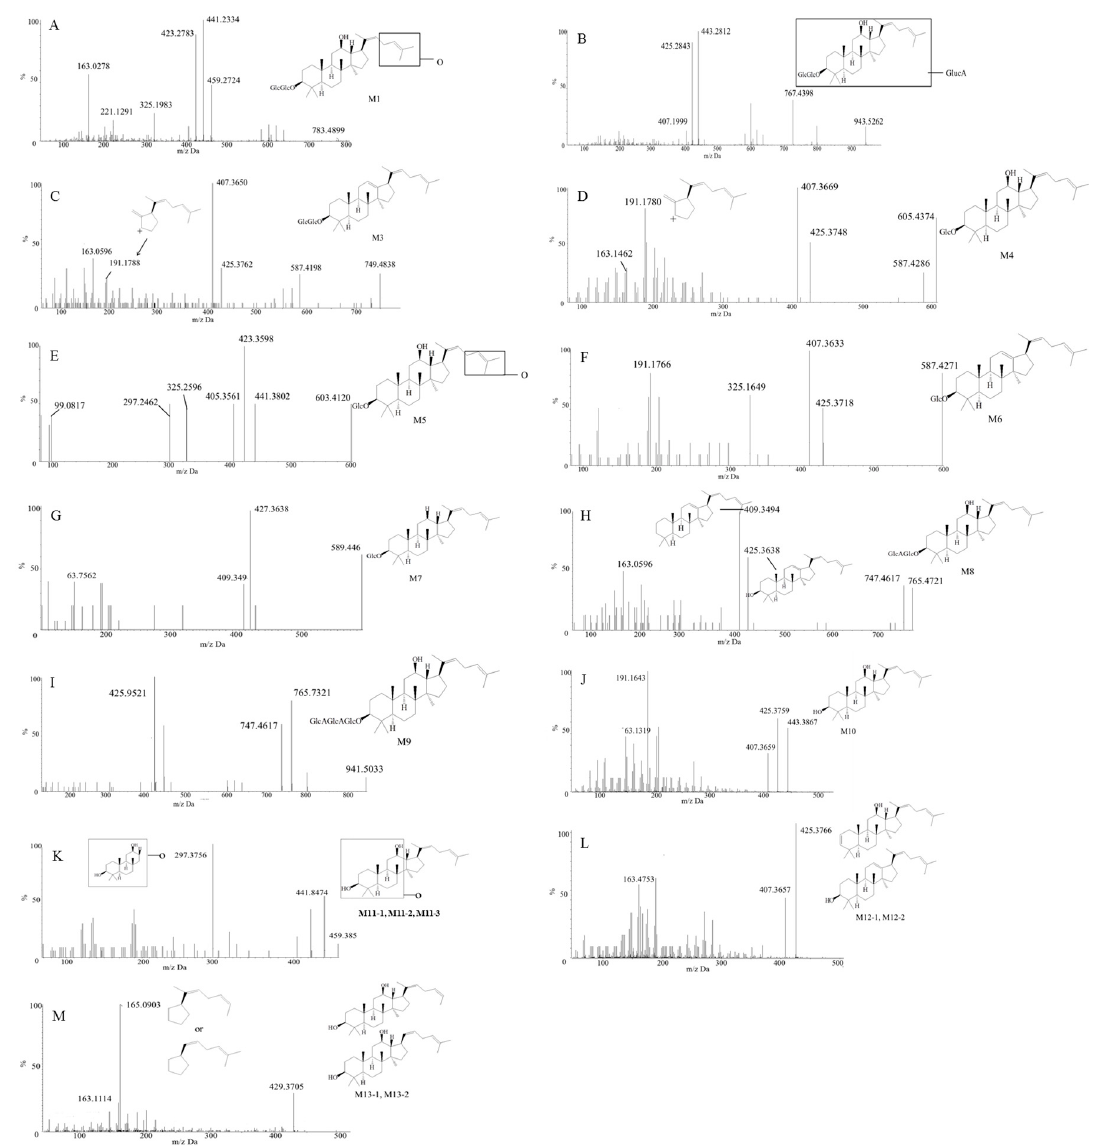
Figure 5. MS spectra of Rg5 metabolites collected from RLMs, urine, feces and plasma on UPLC/QTOF-MS (A–M represents for MS/MS spectrum of the deprotonated metabolite